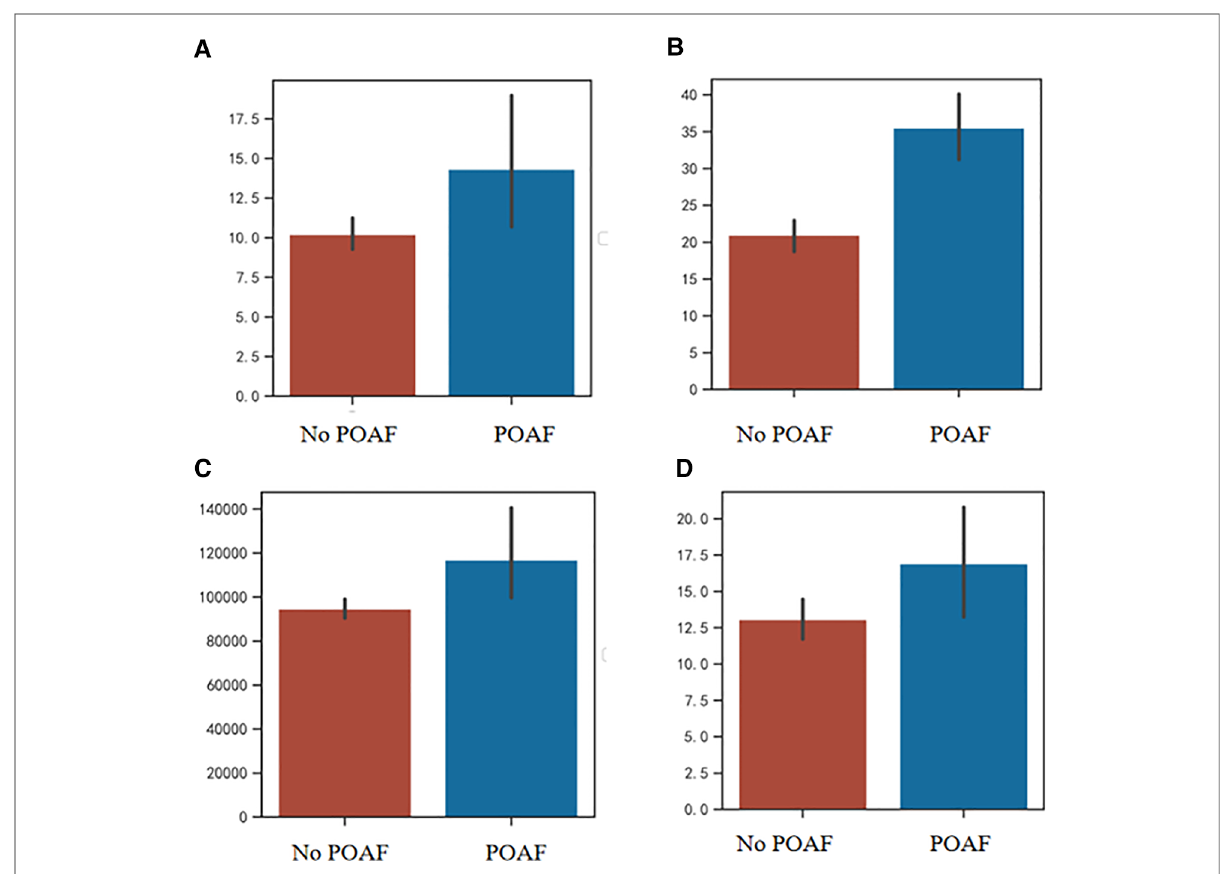
FIGURE 1 ( A ) Comparison of thoracic tube stay between POAF group and no POAF group; ( B ) Comparison of CCI between POAF group and no POAF group; ( C ) Comparison of hospital expenses between POAF group and no POAF group; ( D ) Comparison of postoperative hospital stay between POAF group and no POAF group. POAF, postoperative atrial fi brillation; CCI, comprehensive complication index.